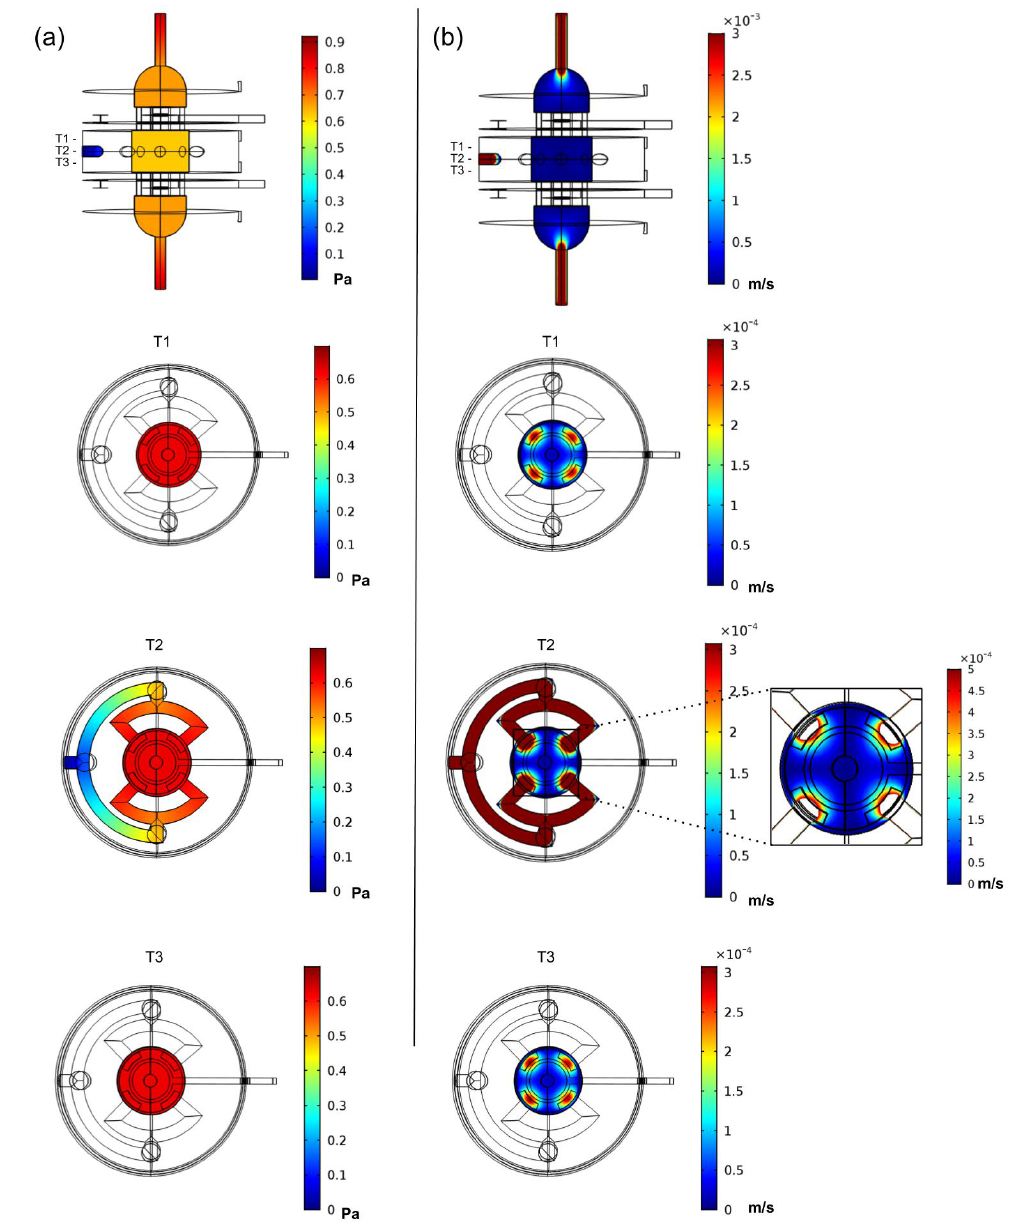
Figure 5. Numerical FEA analysis of the proposed bioreactor design for a laminar perfusion flow with lateral and top slice views. The three top views represent the ROI upper slice (T1), the ROI middle plane slice (T2) and the ROI bottom slice (T3). ( a ) Pressure distribution predicted considering applied inlets velocity of 0.003 m/s and a outlet pressure of 0 Pa. ( b ) Fluid velocity distribution predicted for the same inlet/outlet conditions. The velocity distribution at the ROI middle plane slice is presented in more detail in a top view inset at the right of the slice